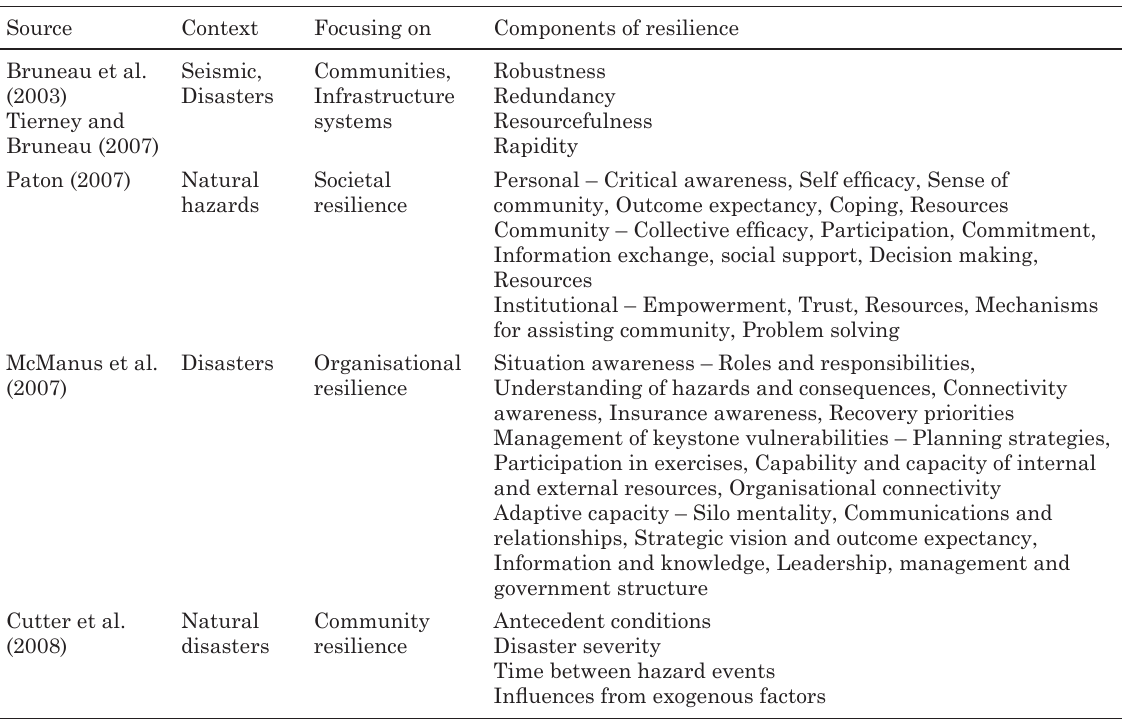
table 2. frameworks on resilience from a hazard